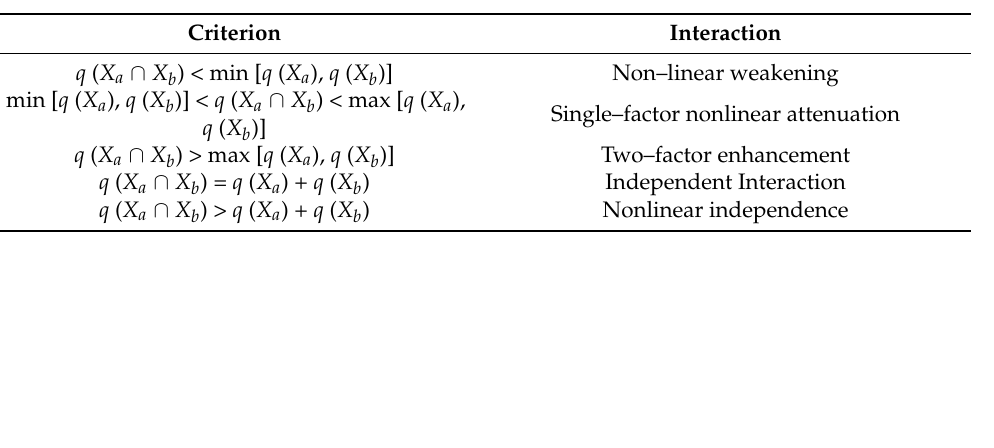
Table 2. Judgment basis of double factor interaction